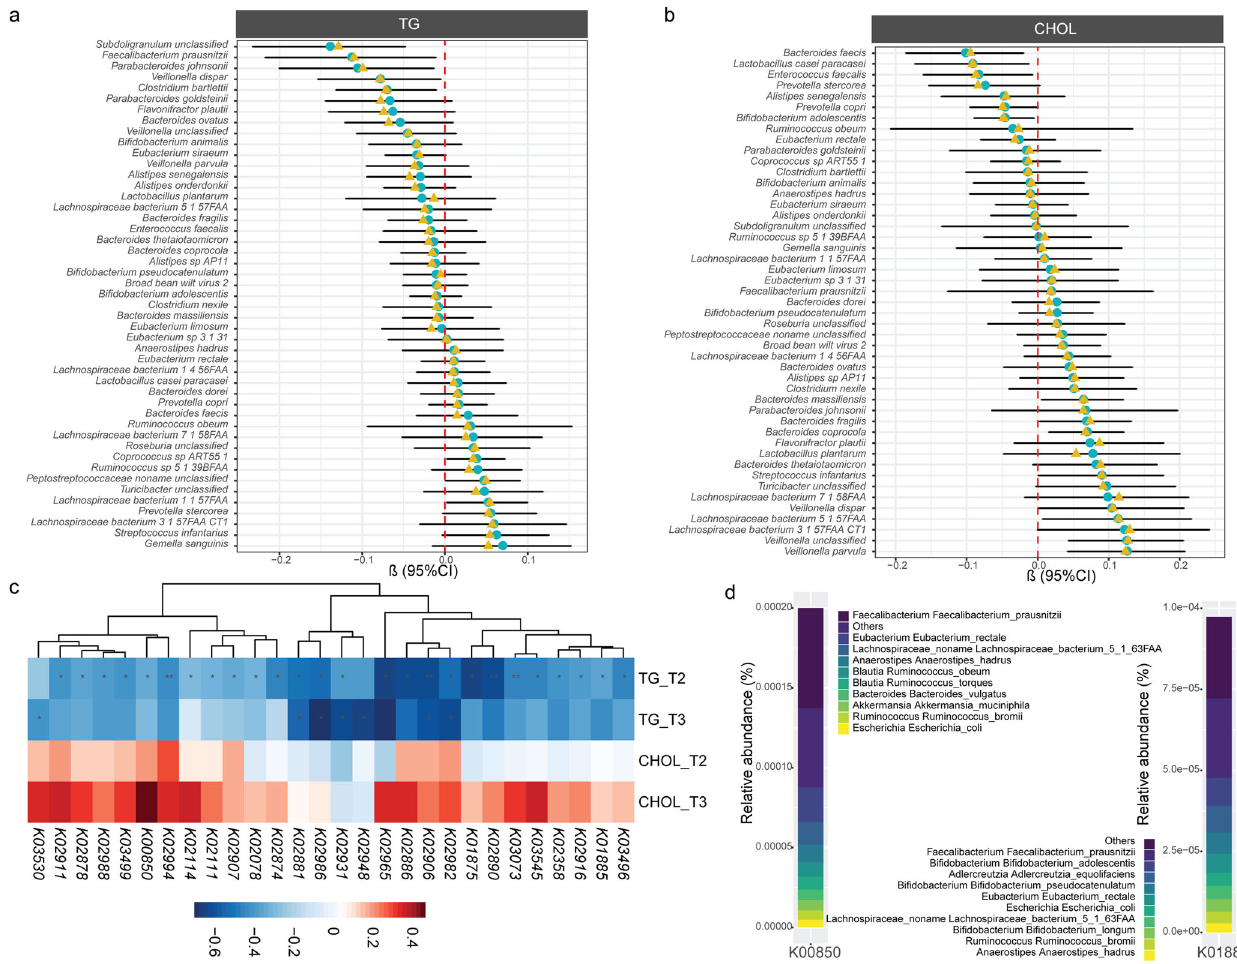
Fig. 5 Association of the gut microbiota composition and KOs abundance with lipid levels. a Association of key species with TG levels at T2. b Association of key species with CHOL levels at T2. c Signi fi cant KOs associated with lipid levels during pregnancy. d Taxa contributing to KOs signi fi cantly associated with lipid